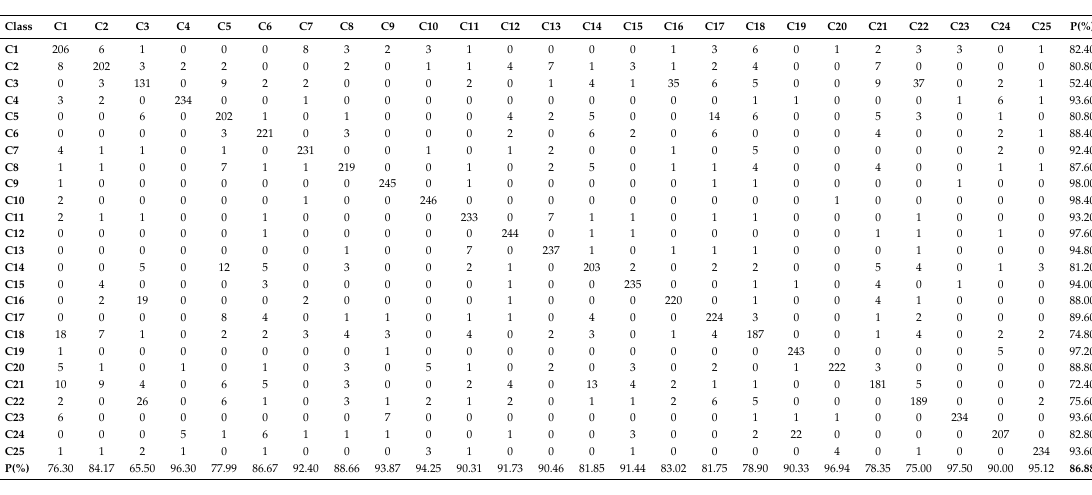
Table 7. Confusion matrix of classification results based on VGG.